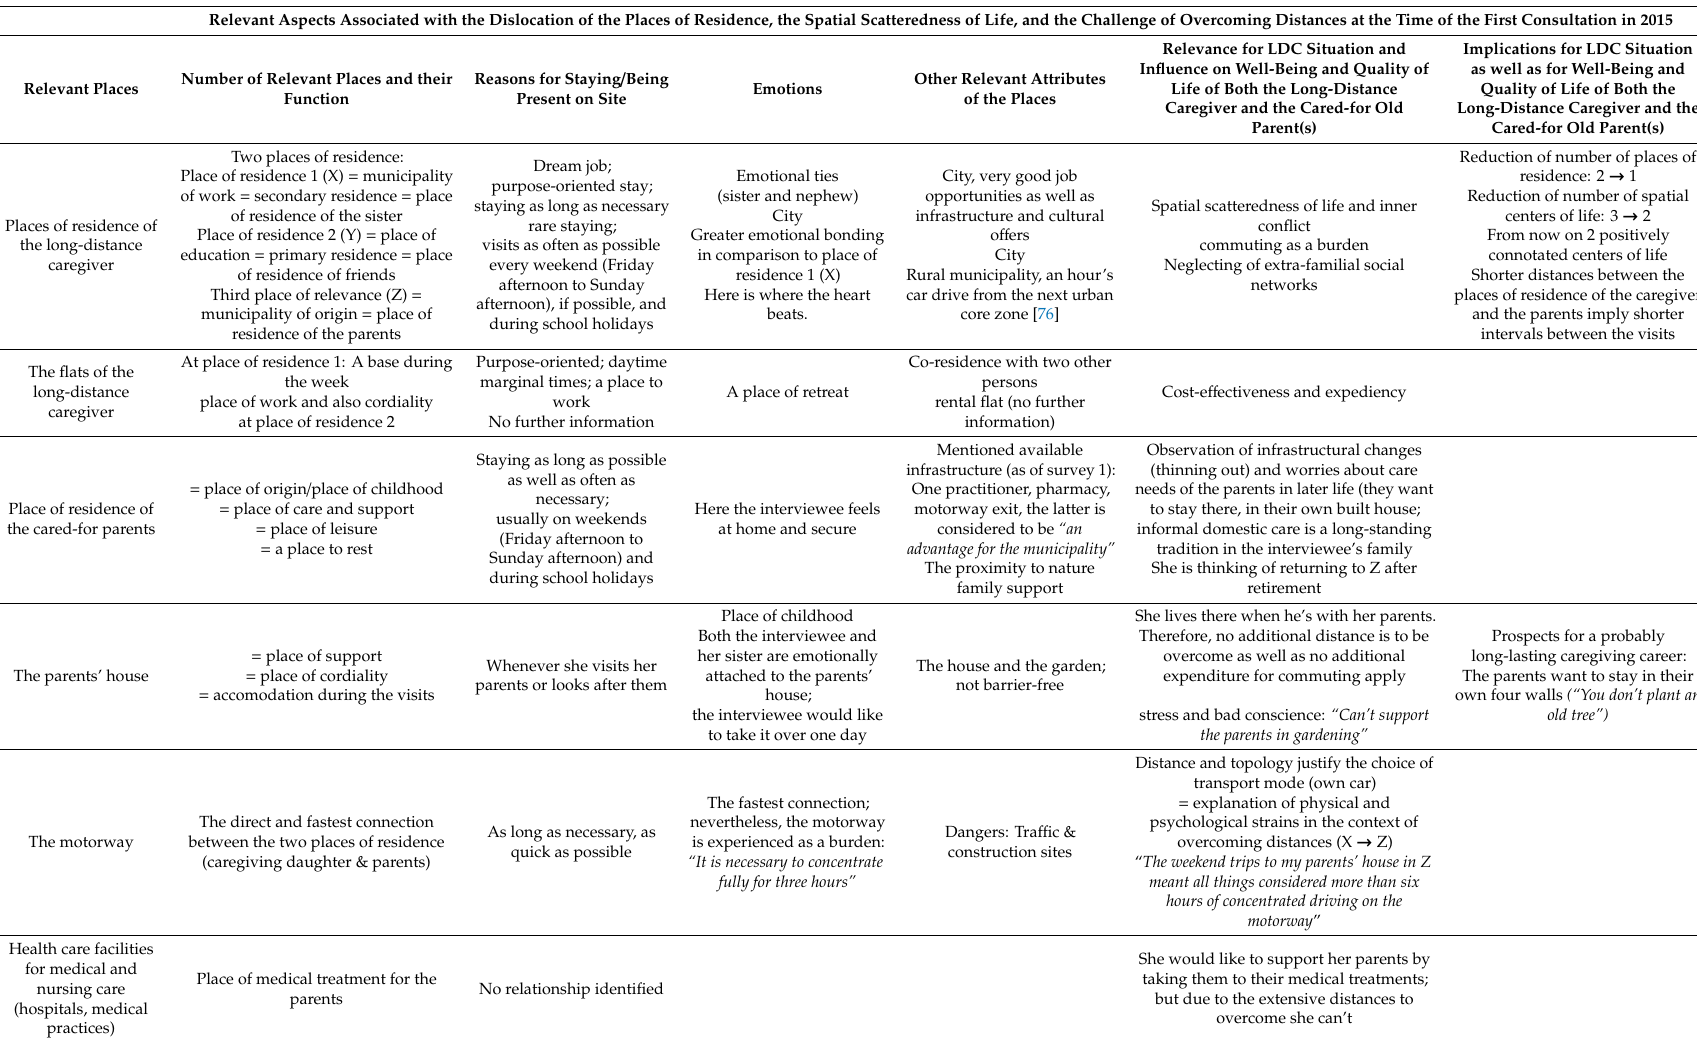
Table A2. Relevant places and their spatially related attributes from the perspective of the long-distance caregiver (“spatial-related scatteredness of life and ambivalence of feelings”). Relevant Aspects Associated with the Dislocation of the Places of Residence, the Spatial Scatteredness of Life, and the Challenge of Overcoming Distances at the Time of the First Consultation in 2015 Implications for LDC Situation Relevance for LDC Situation and Influence on Well-Being and Quality of as well as for Well-Being and / Being Other Relevant Attributes Quality of Life of Both the Life of Both the Long-Distance Relevant Places Number of Relevant Places and their Function Reasons for Staying Present on Site Emotions of the Places Long-Distance Caregiver and the Caregiver and the Cared-for Old Parent(s) Cared-for Old